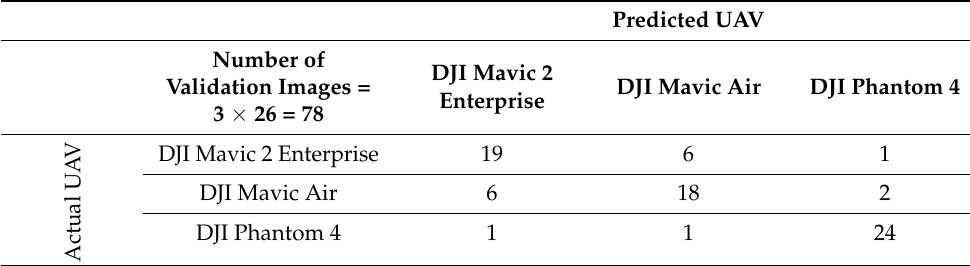
Table 5. Confusion Matrix for Prediction of Test Images Using Trained MobileNet v2